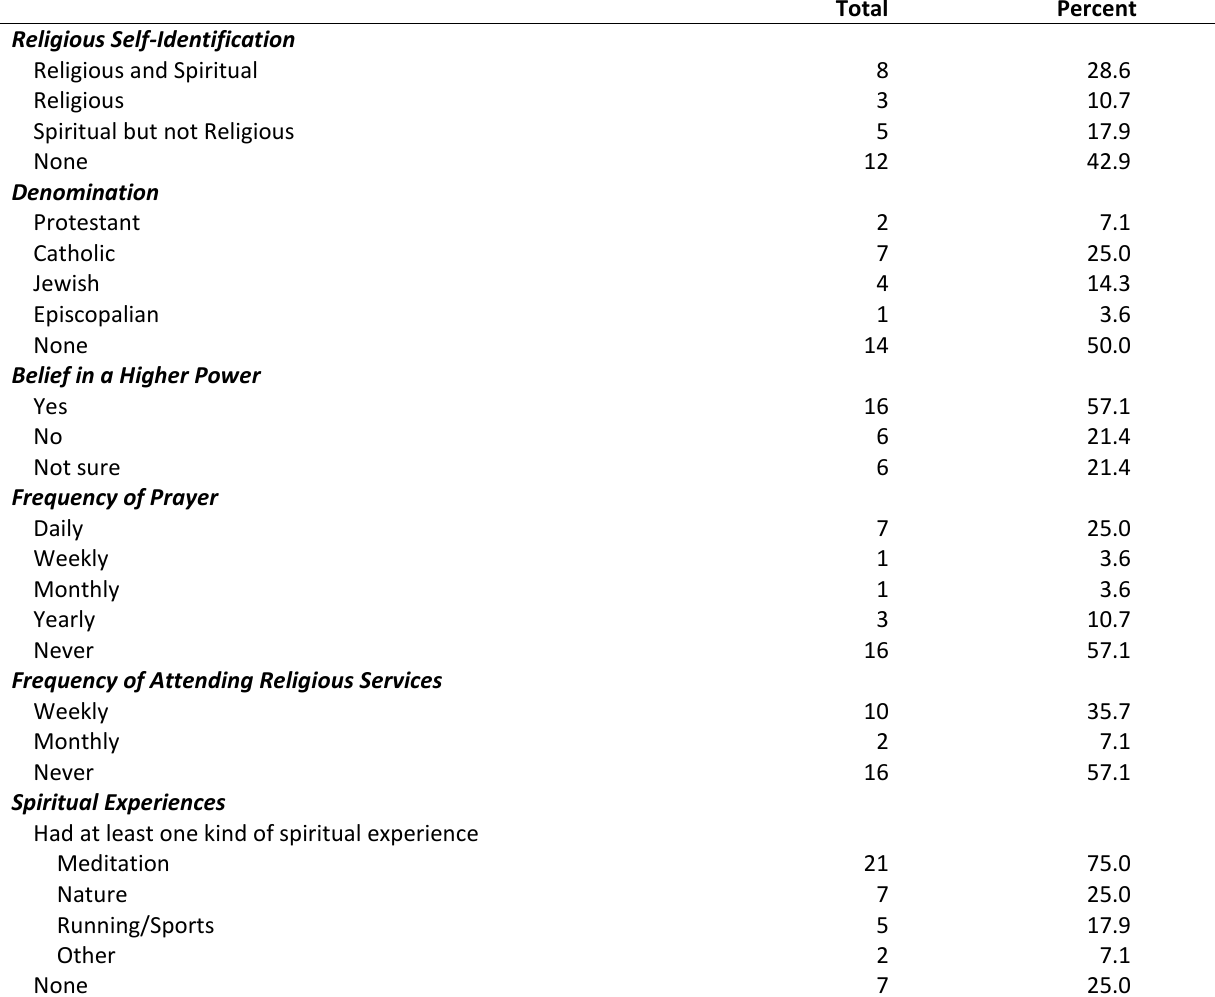
Table 1. Religiosity and spirituality of randomly selected respondents ( N = 28).